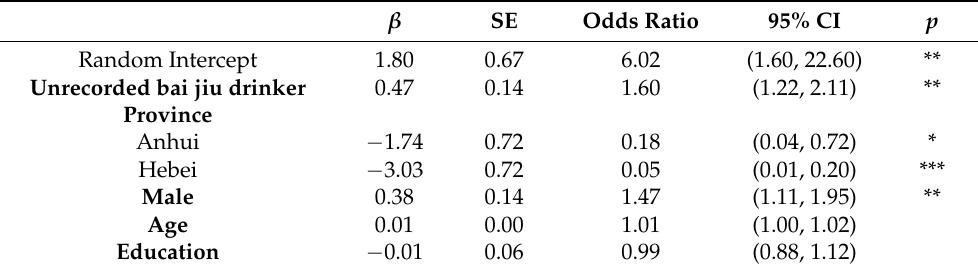
Table 6. Two-level logistic regression model of the effect of unrecorded bai jiu drinker and province on strength of alcohol consumed on memorable occasions.